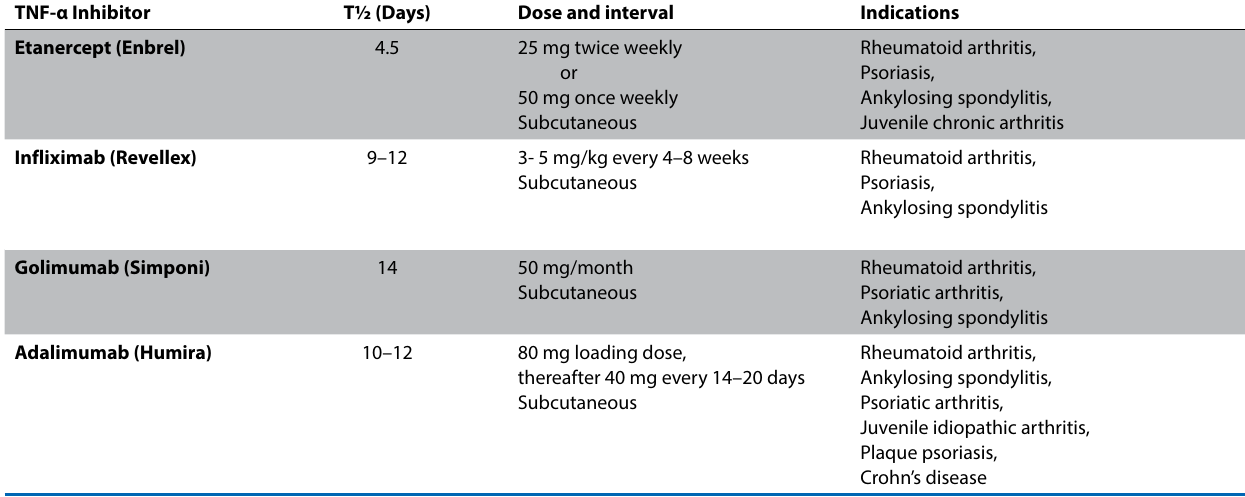
Table 1: TNF-α inhibitors kinetics and indications TNF-α Inhibitor